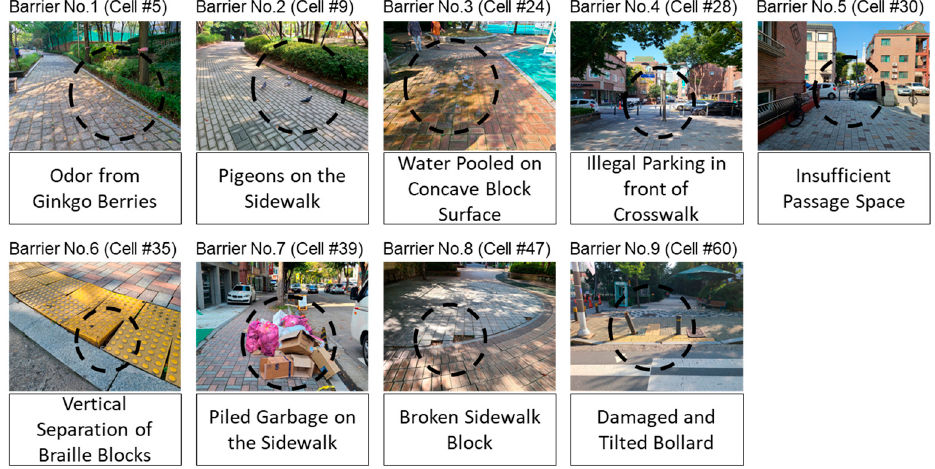
Figure 3. Captured environmental barriers as indicated by participants.